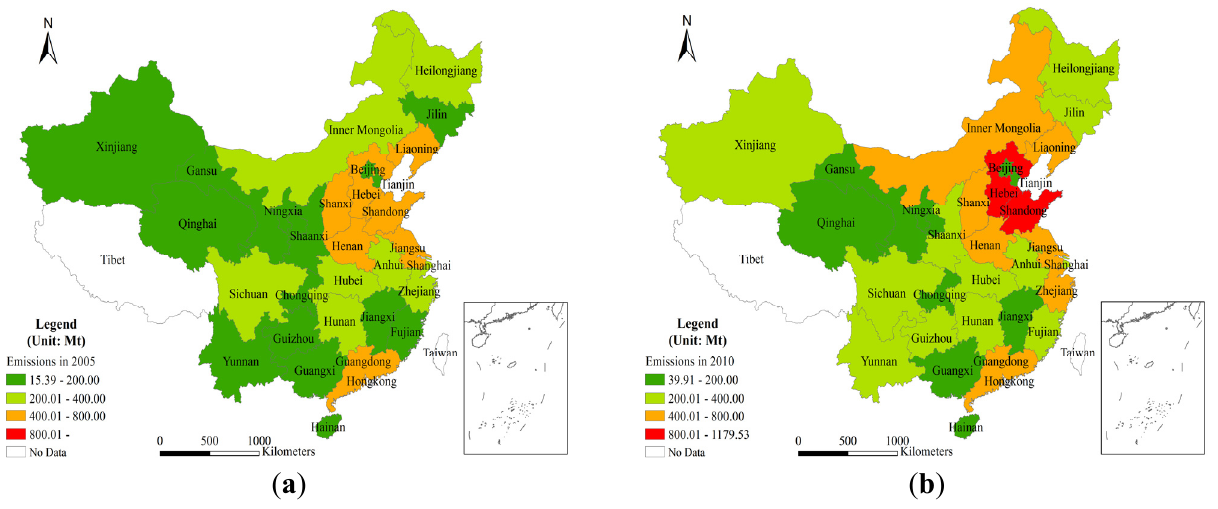
Figure 6. Provincial emission distribution ( a ) CO 2 emissions in 2005; and ( b ) CO 2 emissions in